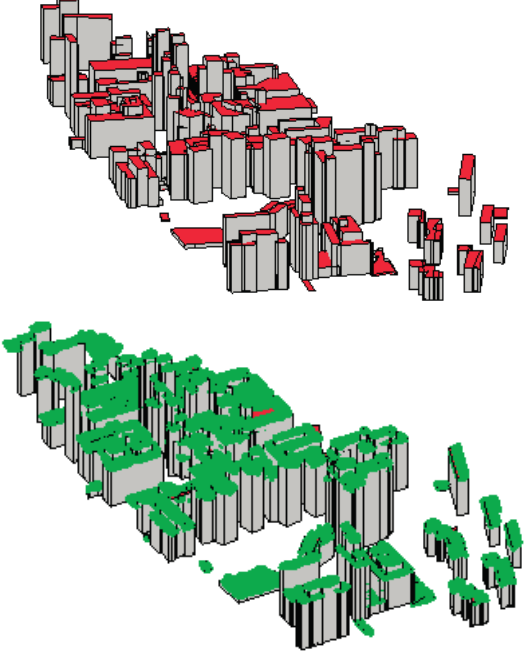
Figure 23. Building model height evaluation. ( up ) Building models, with roofs in red and facades in gray. ( down ) Original ALS building roof points in green and building models in